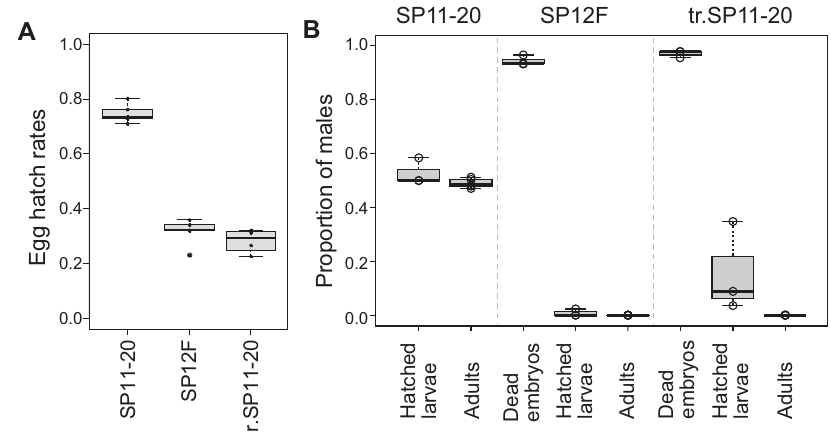
Fig. 1 | Male-killing occurs during late embryogenesis. A Egg hatch rates of a normal line (SP11-20), an all-female matriline (SP12F), and a transinfected line (tr.SP11-20) of D. biauraria . Box plots represent the median, the fi rst quartiles and third quartiles with whiskers drawn within the 1.5 IQR value. Points outside the whiskers are outliers. SP11-20: n =180, 152, 135, 373, and 879 eggs examined over 5 independent experiments. SP12F: n =120, 135, 199, 217, and 810 eggs examined over 5 independent experiments. tr.SP11-20: n =310, 754, 689, and 866 eggs examined over 4 independent experiments. B Proportion of males of dead (but well-developed)embryos, hatched larvae, andadultsin SP11-20,SP12F,and tr.SP11- 20 (For SP11-20, dead embryos were excluded from the analysis). Box plots represent the median, the fi rst quartiles and third quartiles with whiskers drawn within the 1.5 IQR value. Points outside the whiskers are outliers. Hatched larvae